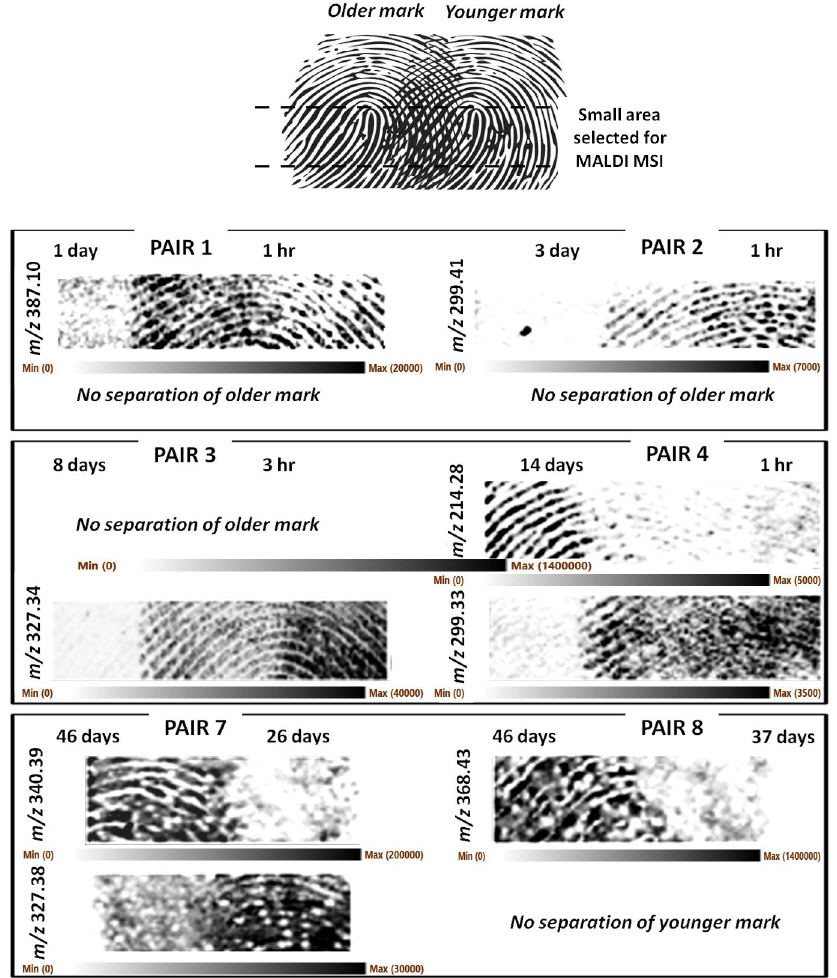
Figure 1. MALDI MS images of six pairs of partially overlapping same-donor groomed fingermarks on aluminium slides. The fingermarks were aged for the times indicated in the figure and in Table 1. Top part of the figure illustrates the schematics of the pair arrangements. Pairs 5 and 6 reported in Table 1 did not yield any suitable fingermark images and were not shown. Older marks